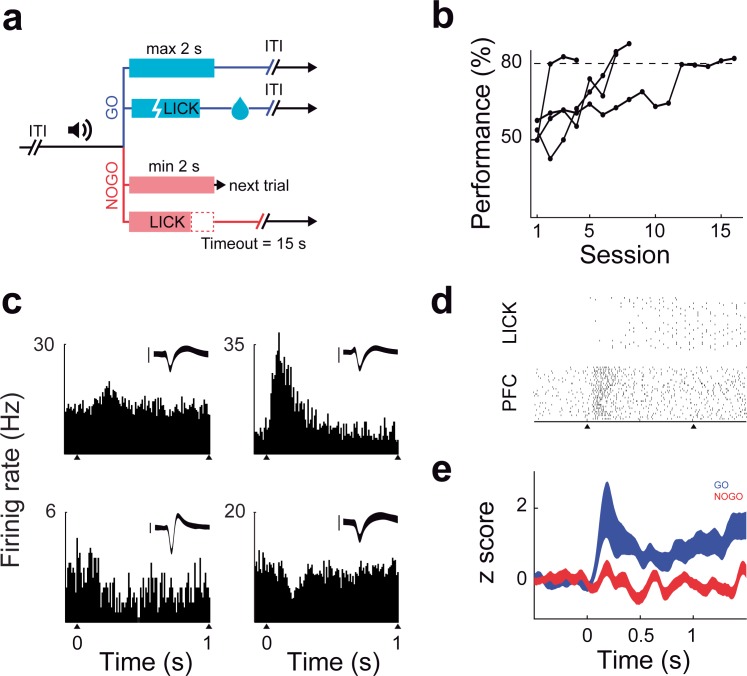
Training protocol, behaviour and neural activity.(a) Animals (n = 6) were trained in a GO/NO-GO paradigm. After a random 1–3 s pre-stimulus delay, a 1 s tone (1 KHz or 8 KHz) was presented. Licking responses were measured during a two seconds opportunity window after stimulus offset. Rats had to lick during the opportunity window after the GO tone, and avoid licking after the NOGO tone. Only correct GO responses were rewarded with a water drop, while in the case of correct NOGO ones the reward consisted in a reduction in the inter-trial interval (ITI), giving the chance to get water sooner in subsequent trials (b) Animals were trained until they had a session performance higher than 80% (dashed line) with a NOGO performance higher than 60%. (c) Peri-stimulus time histograms (PSTH) of PFC neurons estimated within 10 ms bins. Black triangles mark the onset and offset of the tone. Examples of PFC neuronal activity are depicted to illustrate the different patterns of responses. Insets show neuron spike waveforms (mean ± std), scale bar = 200 μv) (d) Raster plots showing the activity of a PFC neuron and the licking responses during 30 consecutive GO trials. (e) Z-Scored PSTHs for 95 neurons in PFC during GO trials (blue) and NOGO trials (red), mean ± s.e.m. values are shown. Compared with NOGO trials, the activity of PFC neurons in GO trials was higher during and after tone presentation (P<0.05, Sign test, measured at 0.5 ms).